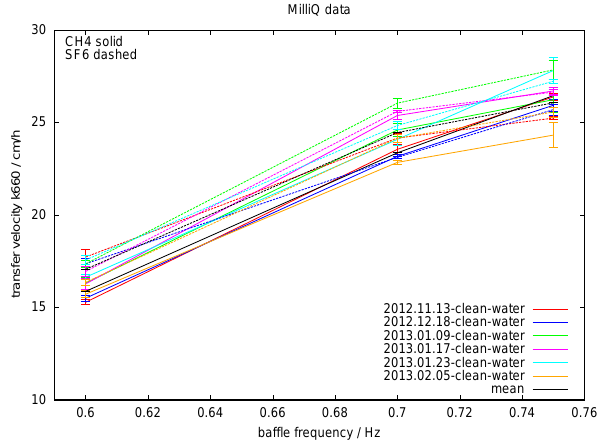
Figure 8. Estimated transfer velocities of Milli-Q water scaled to Schmidt number 660 at three different baffle settings for 6 different experiments, for both CH 4 and SF 6 .